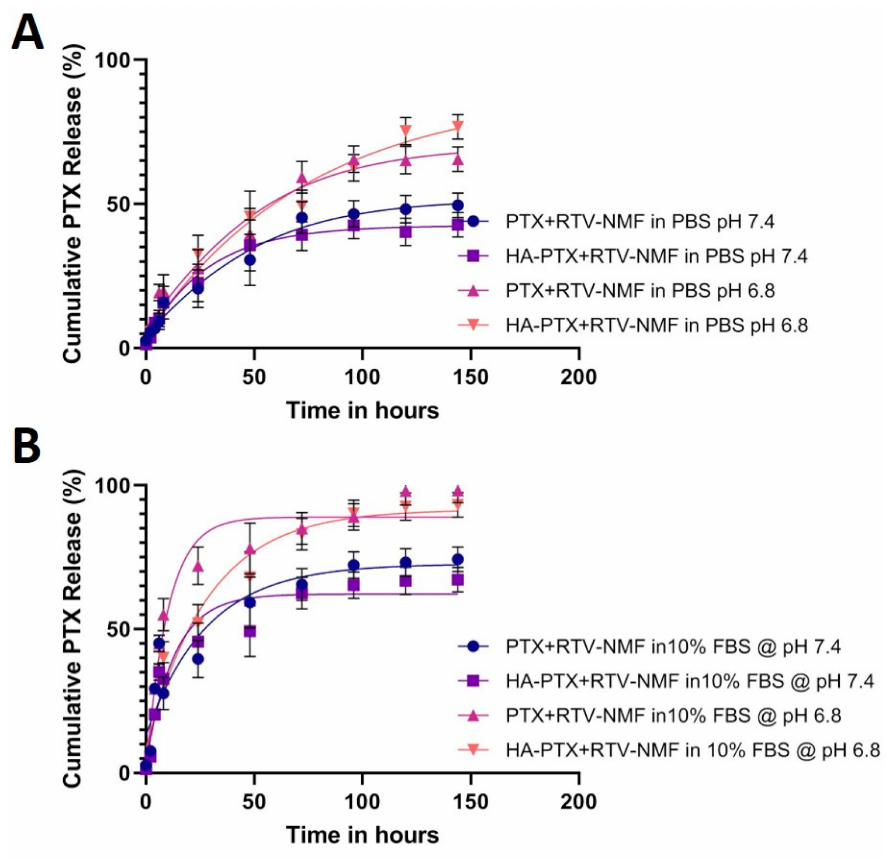
Figure 6. Cumulative PTX release from HA − PTX + RTV − NMF and PTX + RTV − NMF under various buffer conditions. ( A ) Cumulative PTX release from HA − PTX + RTV − NMF and PTX + RTV − NMF in PBB at pH 7.2 and pH 6.8, respectively, over a period of 6 days. ( B ) Cumulative PTX release from HA − PTX + RTV − NMF and PTX + RTV − NMF in 10% FBS solution in DPBB at